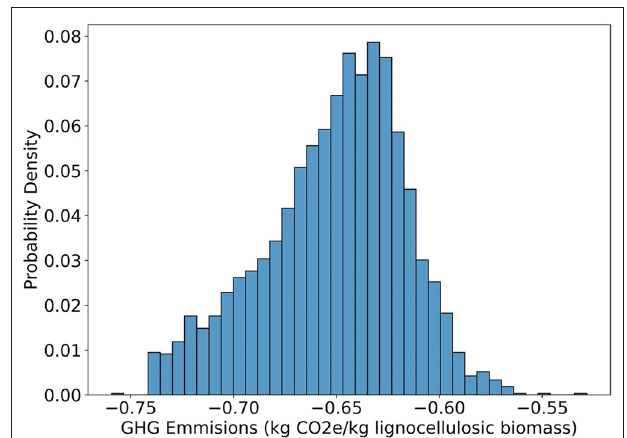
FIGURE 7 | Probability density of greenhouse gas emissions from a lignocellulosic autothermal pyrolysis system producing sugar, phenolic oil, and biochar. Negative emissions represent net carbon removal of atmospheric CO 2